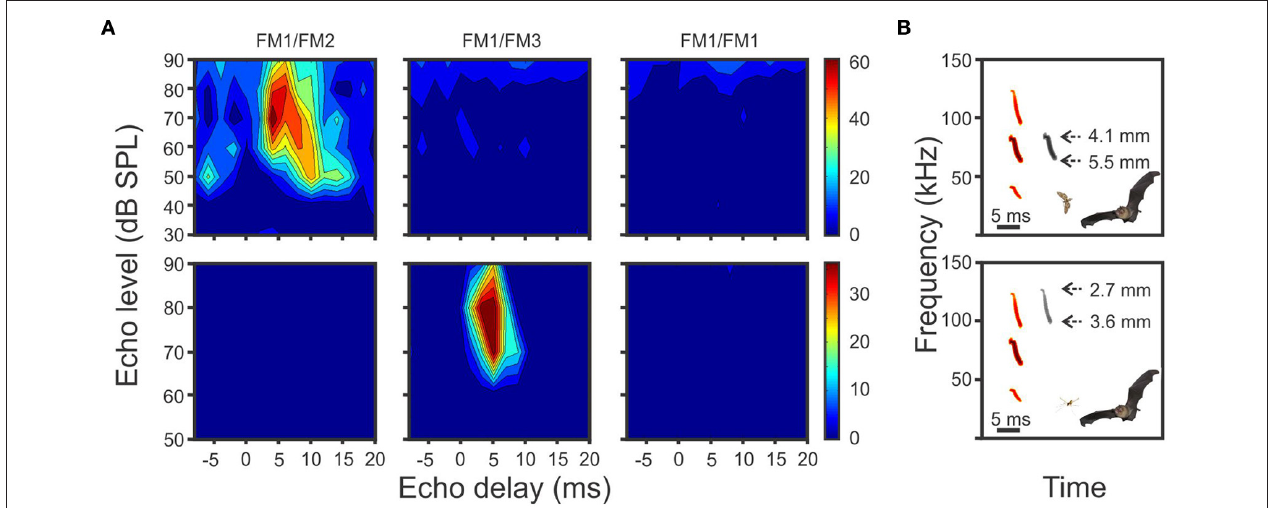
FIGURE 1 | (A) Example delay response areas (DRAs) of two units from P. quadridens . The units were tuned to different harmonic combinations. Responses of the same unit were aligned horizontally. (B) The range of theoretical insect sizes generated from echoes of each biosonar